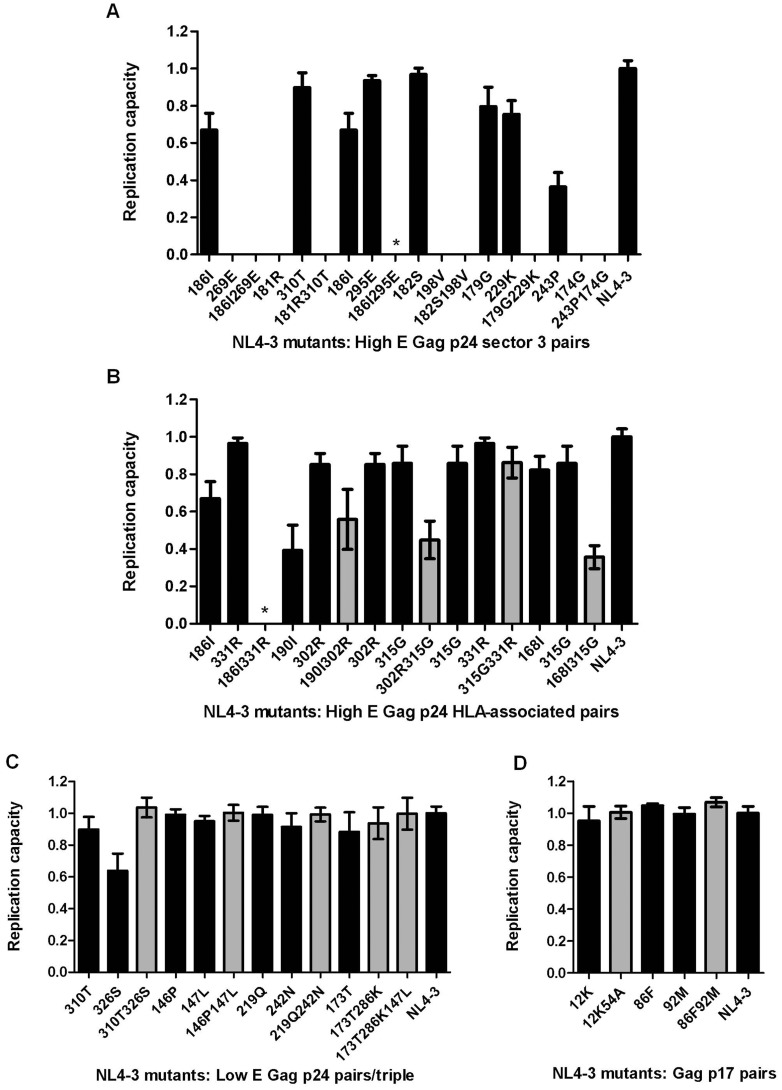
Replication capacities of NL4-3 viruses encoding mutations in HIV-1 Gag.Graphs show replication capacities of NL4-3 viruses encoding (A) Gag p24 mutation pairs with high E values that were previously identified to be in vulnerable co-evolving groups [12] and single mutations within these pairs; (B) Gag p24 HLA-associated pairs with high E values and single mutations within these pairs; (C) Gag p24 pairs/triple with low E values as well as single mutations within these combinations; and (D) Gag p17 pairs including single mutations within the pairs. Those mutants that (i) were not viable or (ii) were not viable unless further mutations developed (indicated with an asterisk), were assigned a replication capacity of zero. Mutation pairs and triples are shown in grey while single mutations within these combinations are shown in black. Replication capacities of mutant viruses are expressed relative to the replication capacity of wild-type NL4-3 virus (RC = 1). Bars represent the mean of three independent experiments and error bars represent standard deviation from the mean.